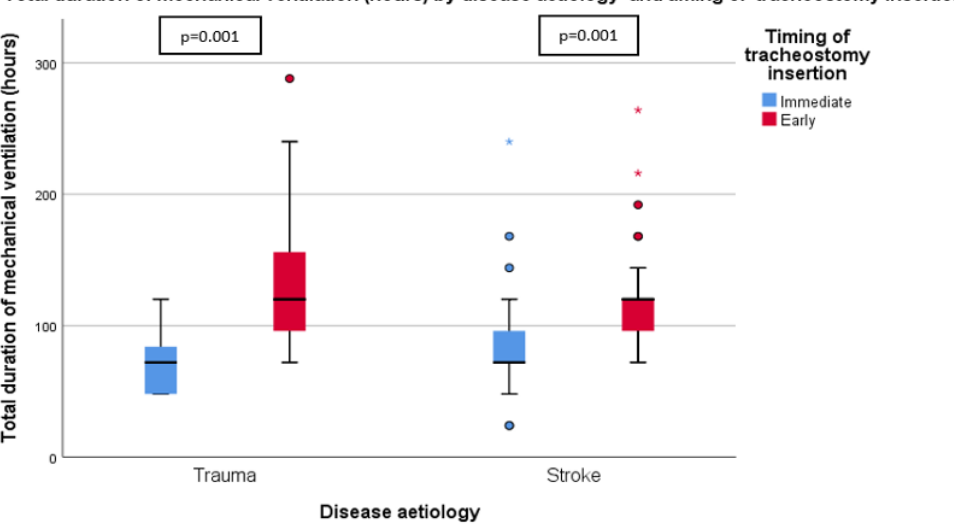
Figure 6. ICU/Neuro HDU length of stay (hours) by disease aetiology and timing of tracheostomy insertion. 4. Discussion There has been discussion on when tracheostomy should be performed on neurosur- gical patients. Prior studies by Elkbuli et al. and Robba et al., where the sample population was heterogeneous, showed that tracheostomy provided benefits in the critical-care situ- ation, such as shorter duration of mechanical breathing and LOS in ICU and HDU [4 – 8,12]. Only few studies looked at the timing of tracheostomy in patients who have had decompressive craniectomy [4,5,12 – 15]. The earlier the weaning period, in terms of me- chanical ventilation and HDU or ICU stay, the sooner the post-operative patient can be moved to the general ward for ongoing care. According to McCredie et al. [15], this will boost the turnover rate for the mechanical ventilators and beds, both of which are badly needed but scarce.